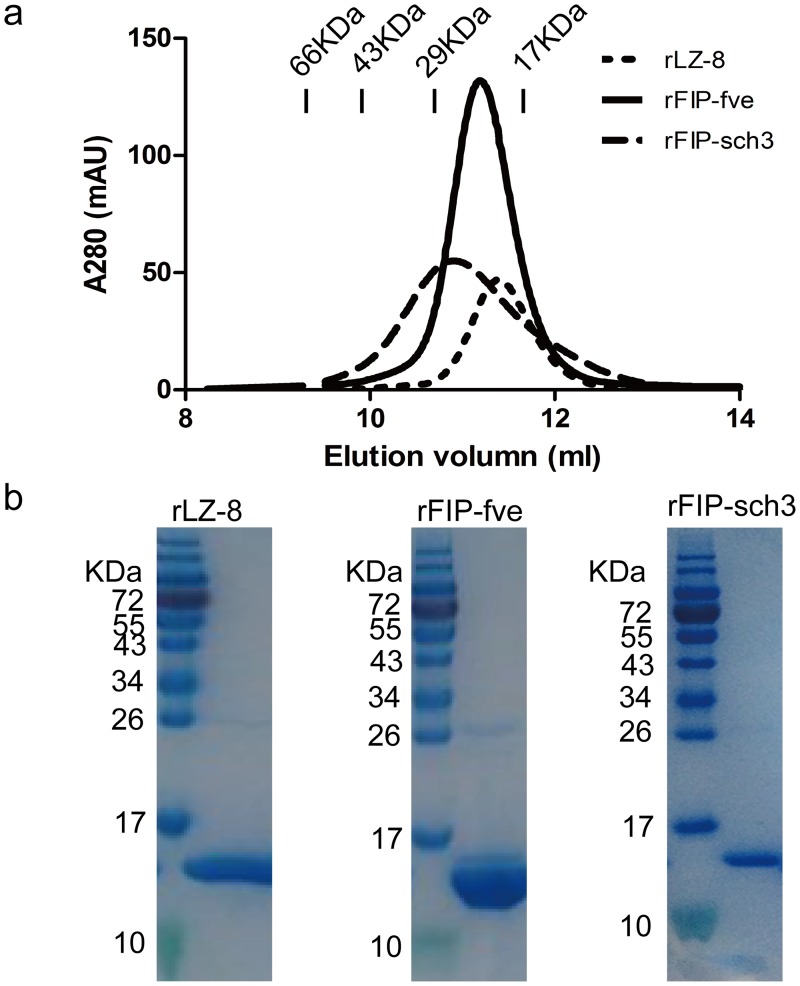
Analysis of purified rFIPs.(a) Gel filtration chromatography of rFIPs after the GST tag was removed. The standard markers noted in the figure are 66, 43, 29 and 17 kDa. Native LZ-8 and FIP-fve are dimers. The calculated molecular weight of FIP-sch3 as a dimer is 28.3 kDa. (b) SDS-PAGE results of purified rFIPs. The samples were purified using gel filtration chromatography. Purified proteins were resolved by 15% SDS-PAGE, stained with Coomassie brilliant blue R-250, and then destained with ethanol-acetic acid-water.